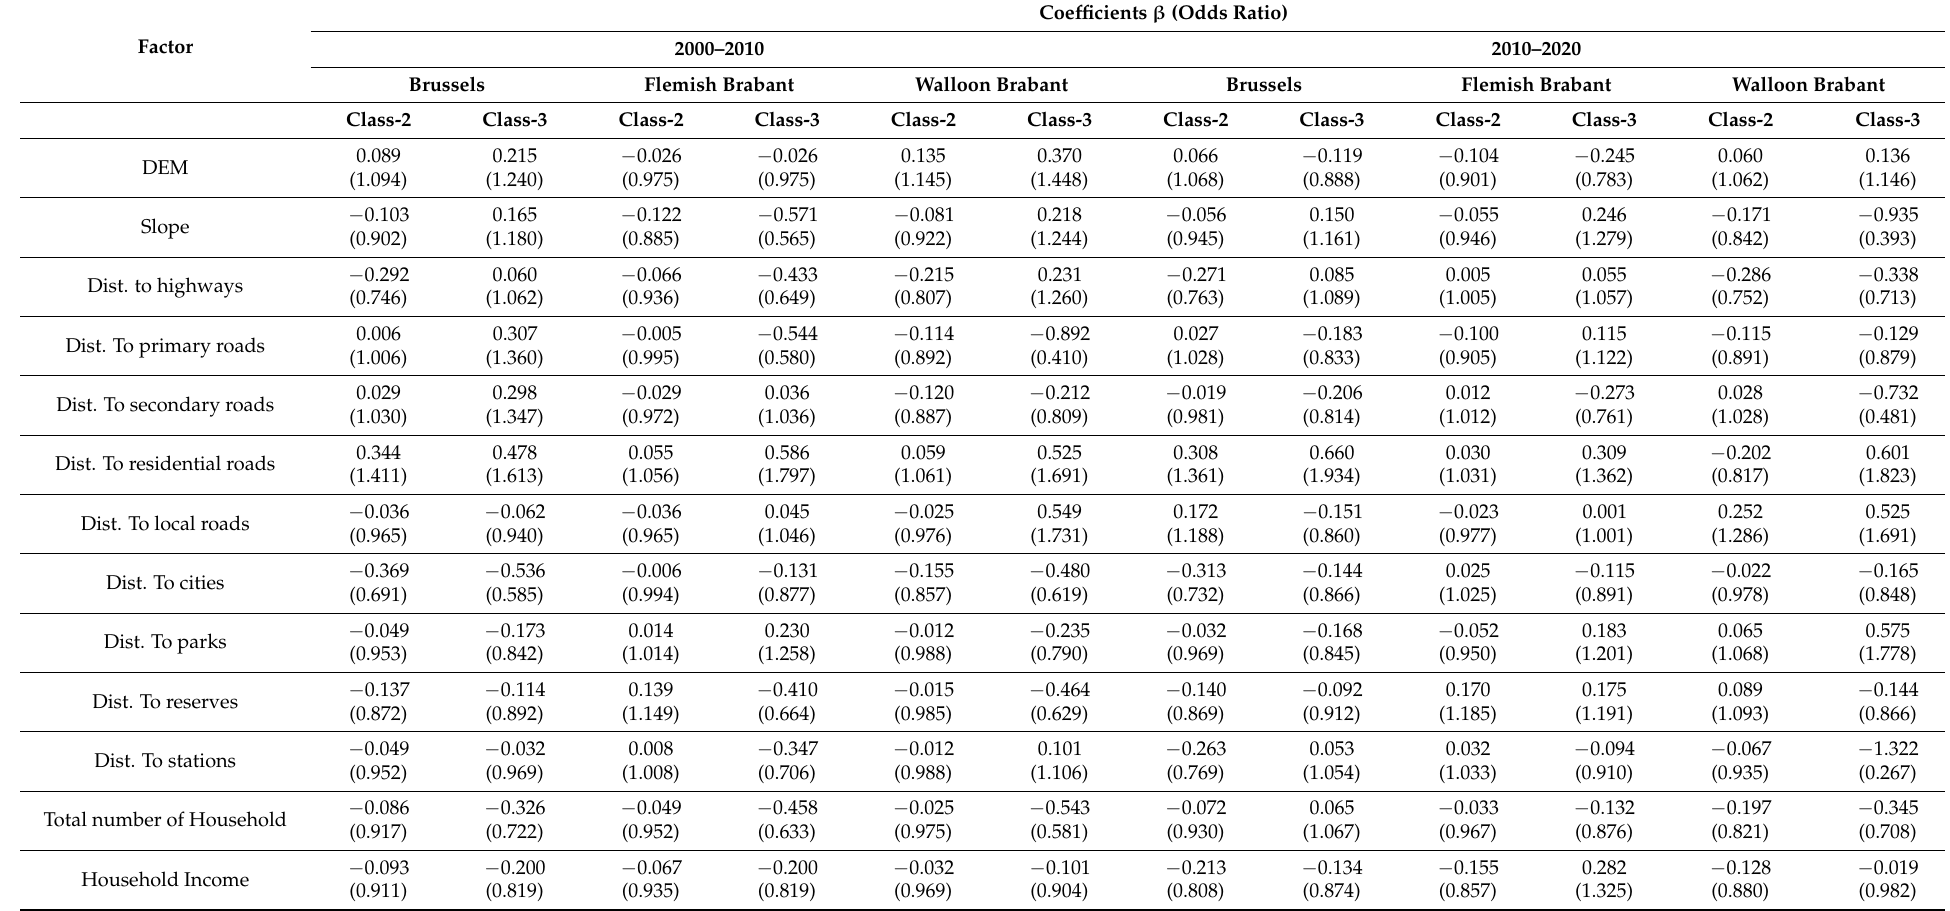
Table 2. Coefficients derived for variables using multinomial logistic regression (reference class: